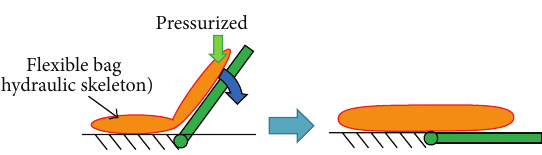
Figure 1: Basic principle of hydraulic skeleton actuator.